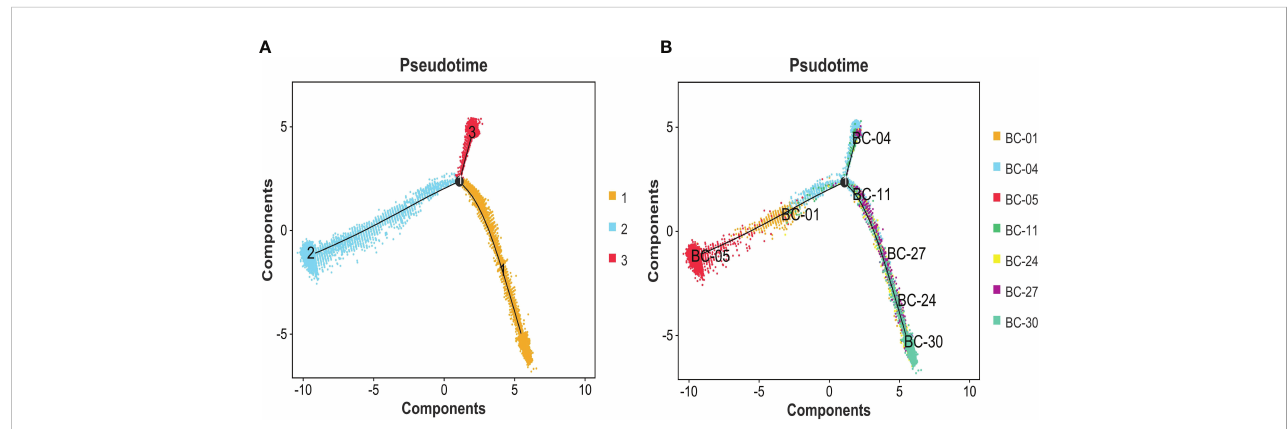
FIGURE 8 (A) Pseudotime analysis was used to construct the trajectory of epithelial cell differentiation in BC groups, divided into three separate evolutionary tracks. (B) Combined with the clinical grading of patients, it is obvious that two trajectory branches are consistent with MIBC, while one trajectory branch corresponds to NMIBC. BC, bladder cancer; MIBC, muscle-invasive bladder cancer; NMIBC, non-muscle-invasive bladder